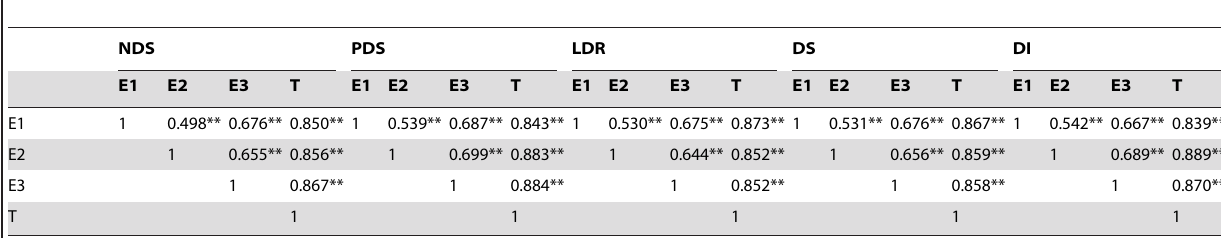
Table 2. Correlation analyses of three environments using mean values of five FHB-related traits.